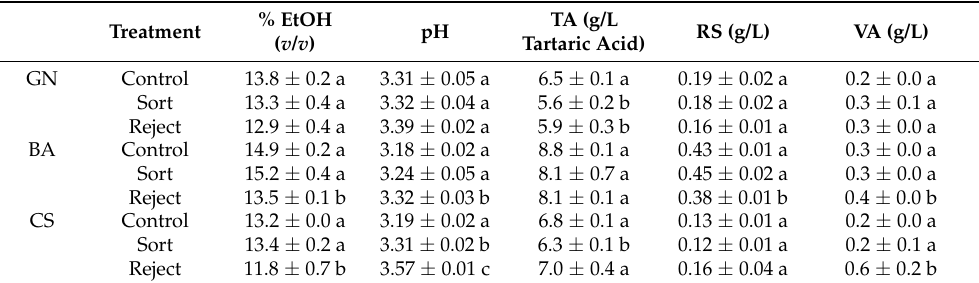
Table 5. Means and standard deviations for basic wine chemistry analysis performed at the time of